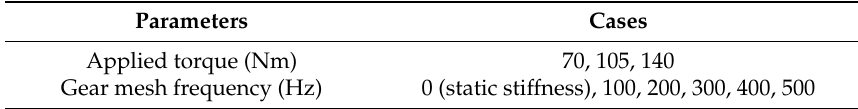
Table 3. Numerical cases.